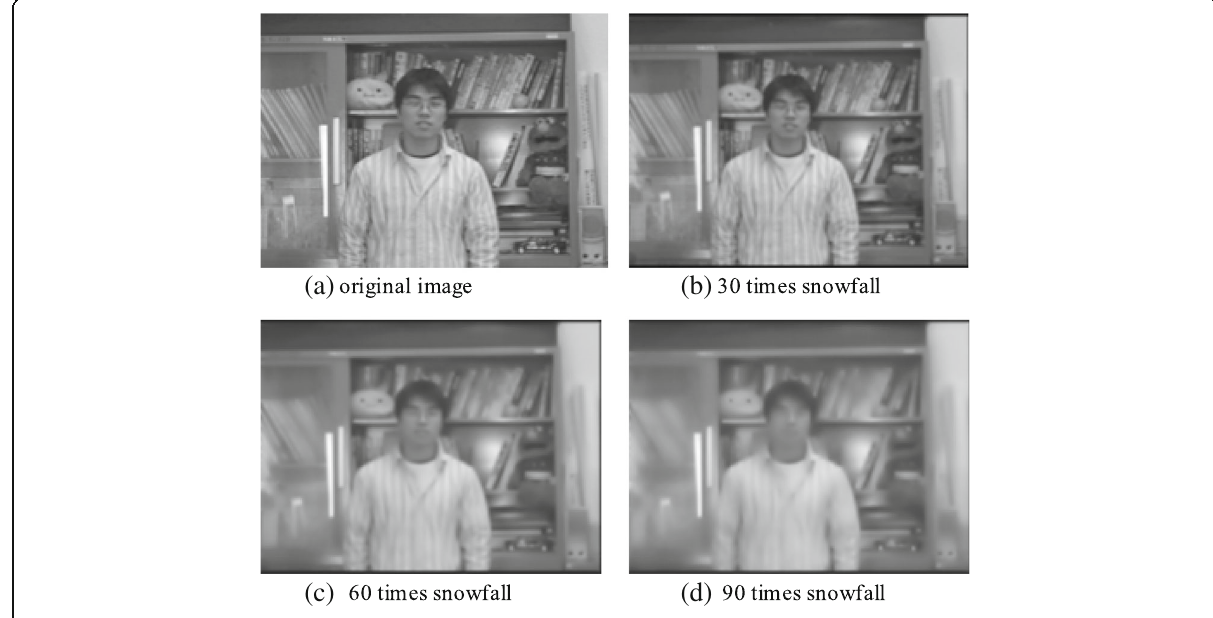
Fig. 6 Snowfall results of an image. a Original image. b 30 times snowfall. c 60 times snowfall. d 90 times